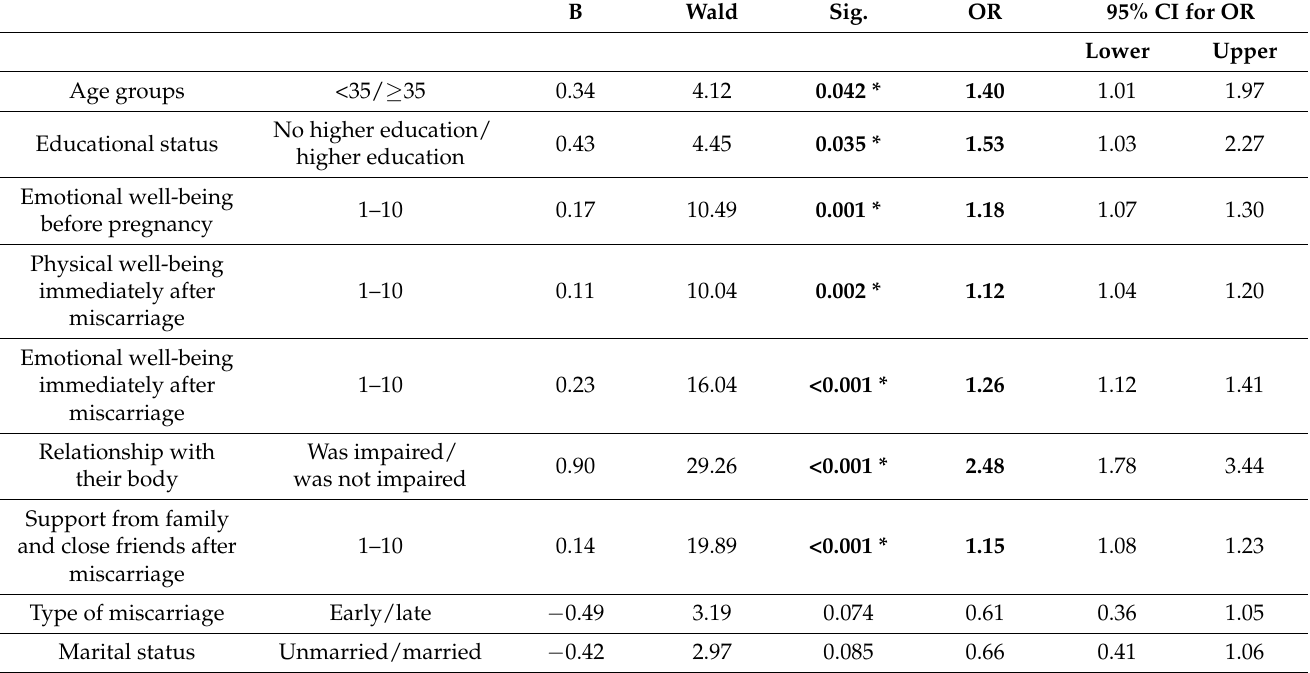
Table 2. Binary logistic regression model for present postnatal depression